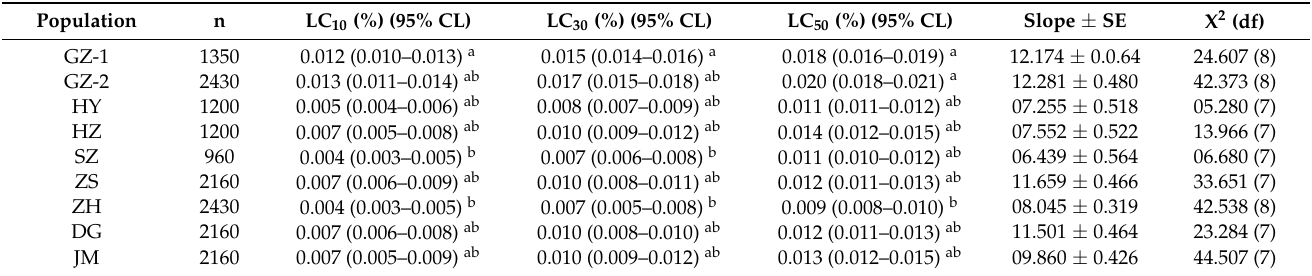
Table 1. LC 10 , LC 30, and LC 50 values of Solenopsis invicta obtained from exposure of